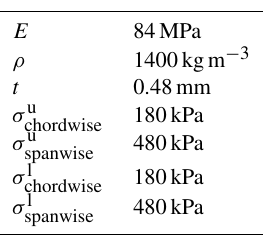
Table 1. Membrane properties (u: upper; l: lower).